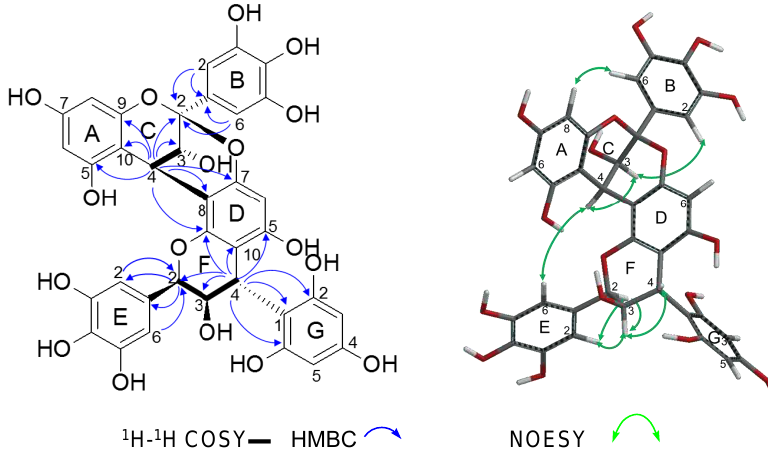
Figure 12. 1 H- 1 H COSY, HMBC, and NOESY correlations of 14 .